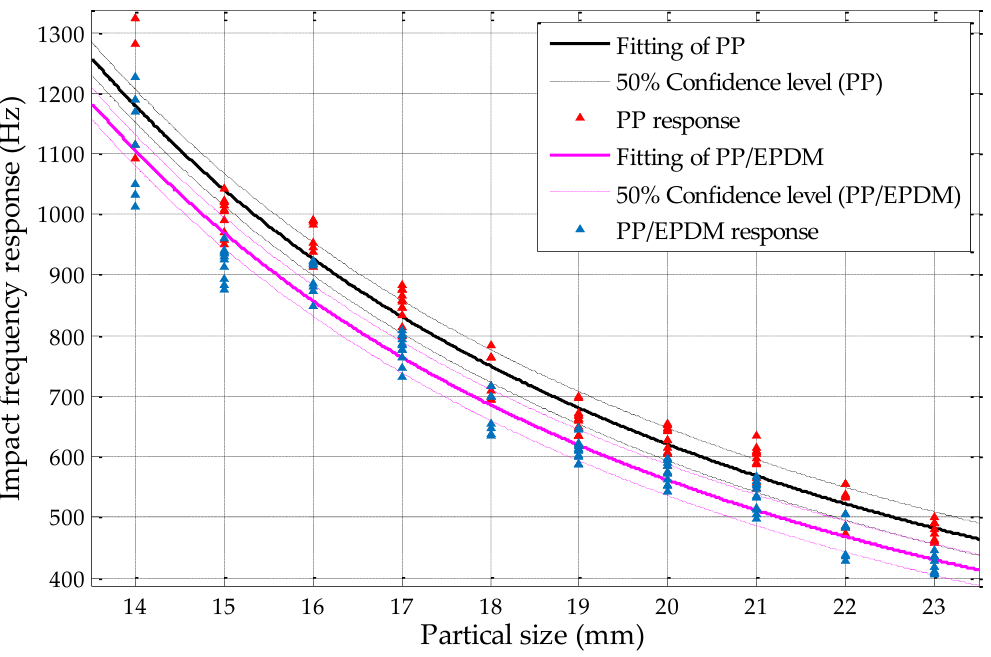
Figure 20. Confidence intervals of PP and PP/EPDM at the 50% confidence level by using fine sieving diameter